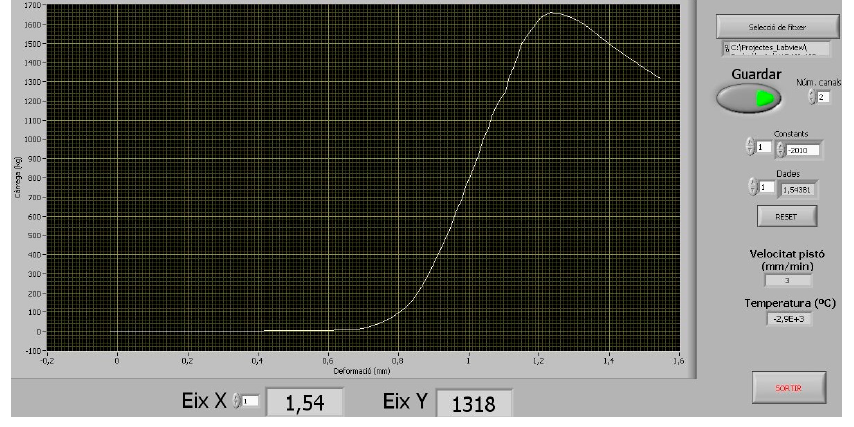
Figure 4. Curve σ - ε resulting from a test.